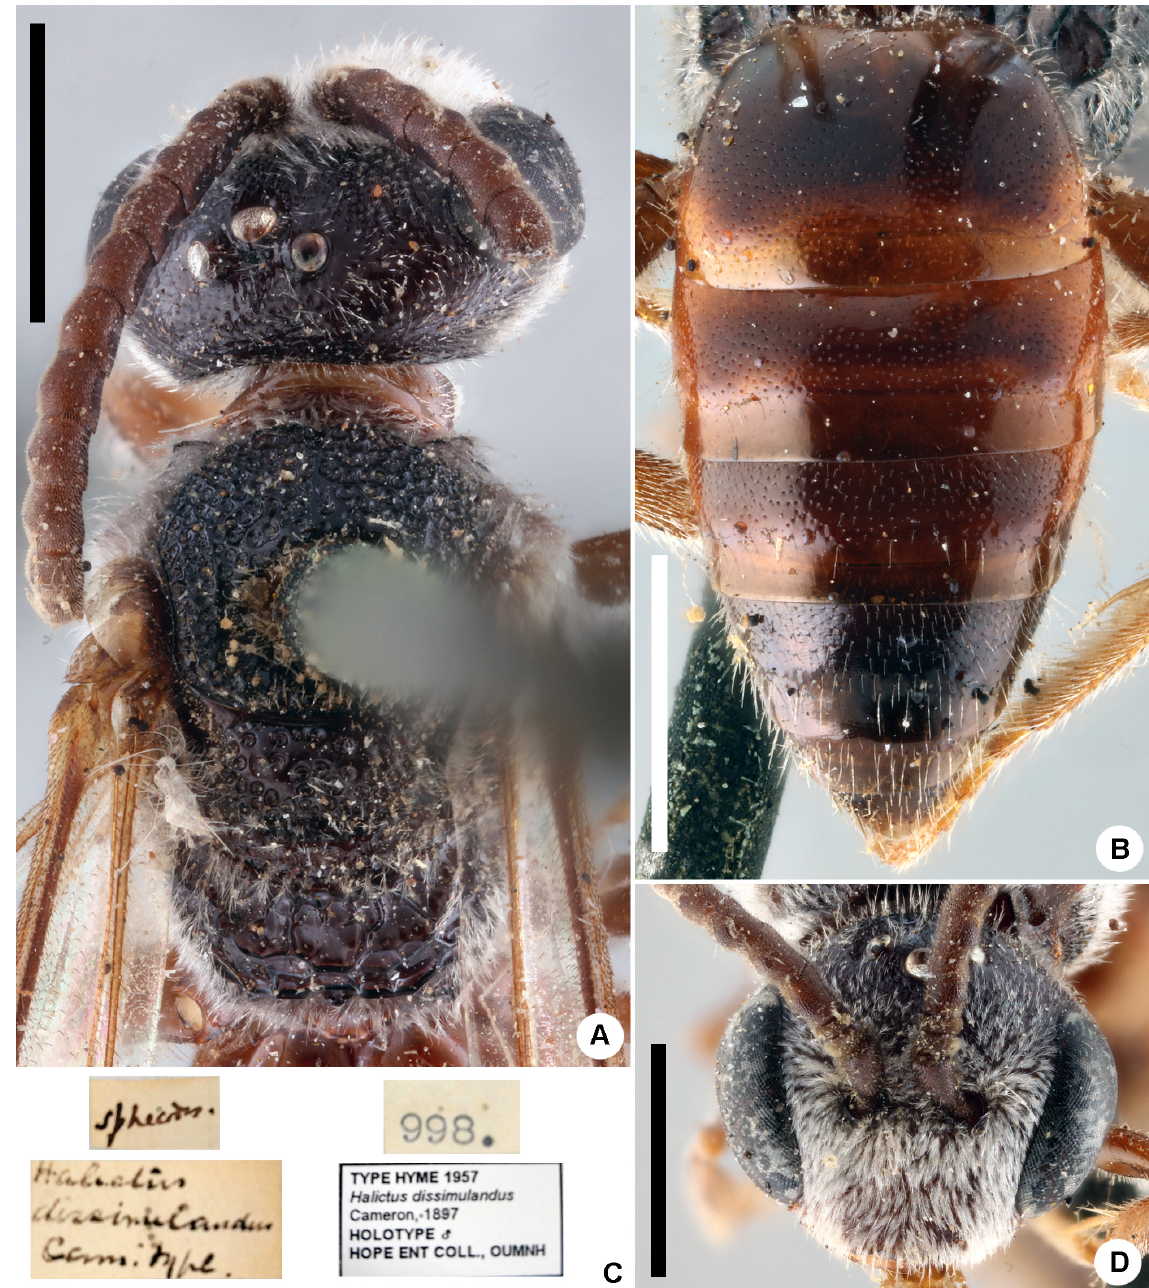
Fig. 8. Sphecodes dissimilandus (Cameron, 1897). Holotype, ♂ (OUMNH). A . Head and mesosoma in dorsal view. B . Metasoma in dorsal view. C . Labels. D . Head in frontal view. Scale bars = 1